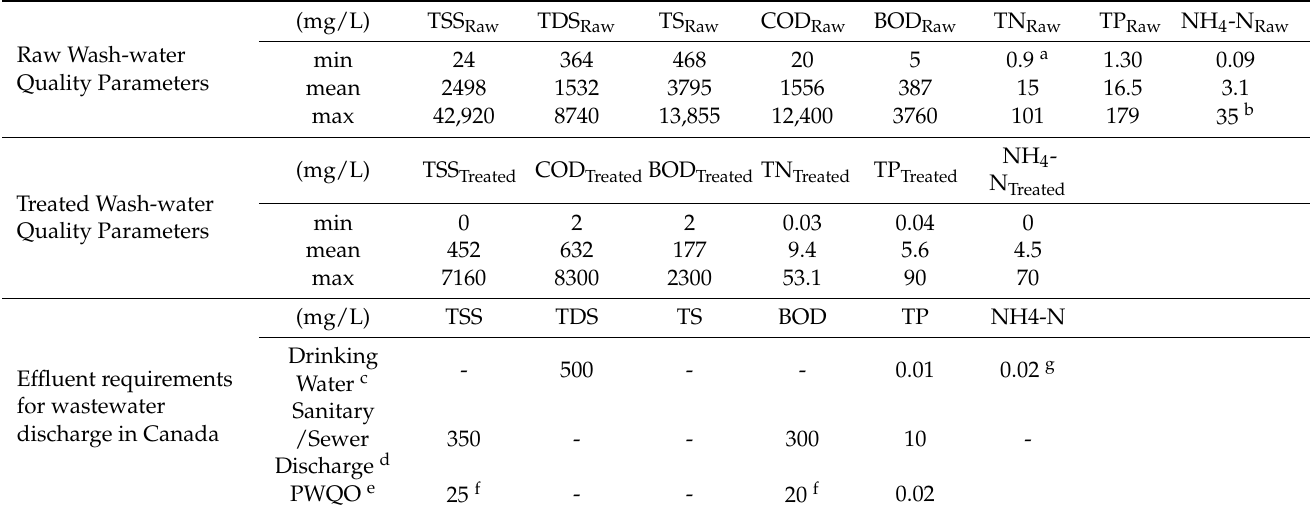
Table 4. Model input and output parameters and their minimum, maximum, and mean